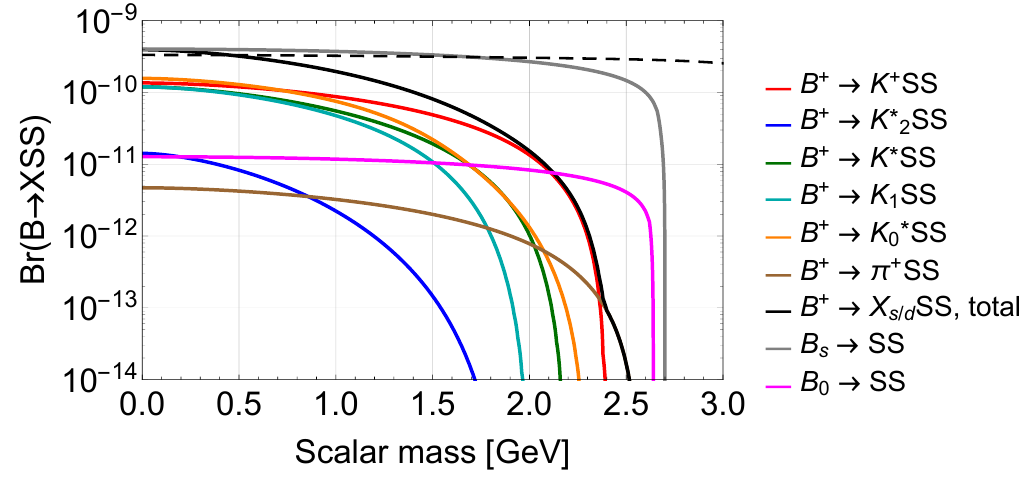
Figure 8 . Branching ratios of decays B + contains a quark q , versus the scalar mass. By the K (cid:3) channel, we denote the sum of the branching ratios for K (cid:3) (892), K (cid:3) (1410), K (cid:3) (1680) (cid:12)nal states, by K (cid:3) | for K 1 (1270), K 1 (1400). The values of the branching ratios are given at (cid:11) = 1